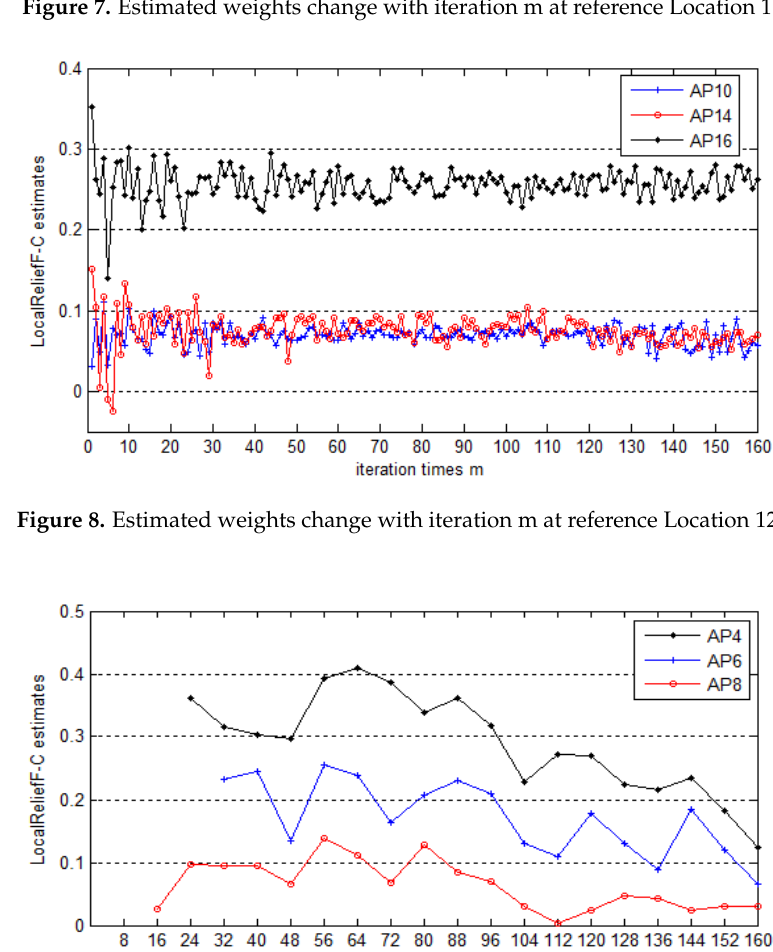
Figure 9. Estimated weights change with the nearest neighbors count k at reference Location 1.